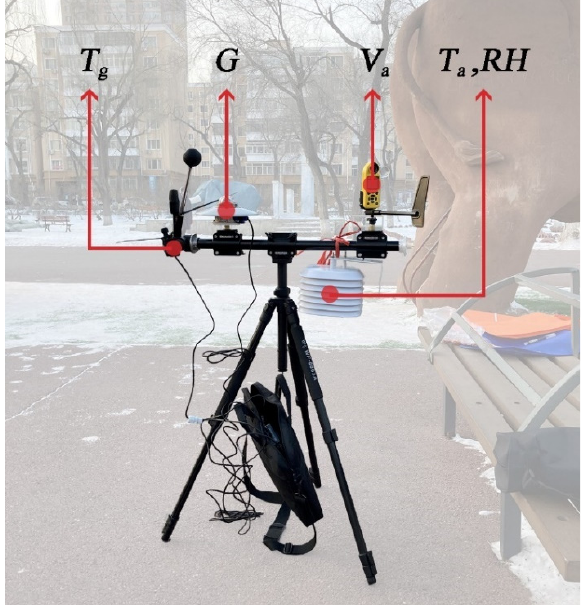
Figure 3. Meteorological measurement apparatus and physical quantities (picture was taken by the author on 18 January 2022). author on 18 January 2022).